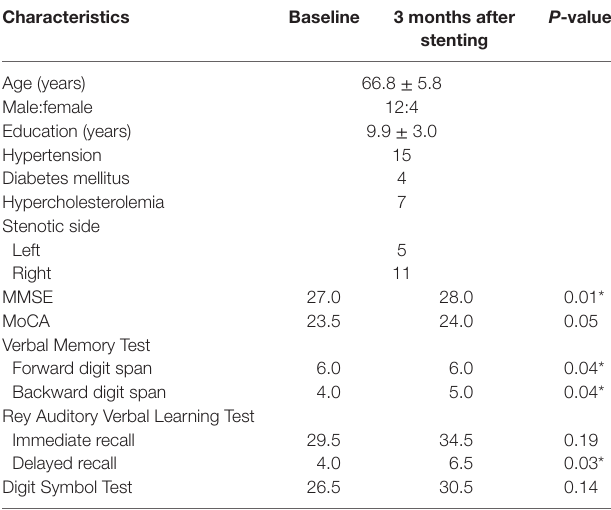
TaBle 1 | Demographic information and neuropsychological test scores at baseline and 3 months after